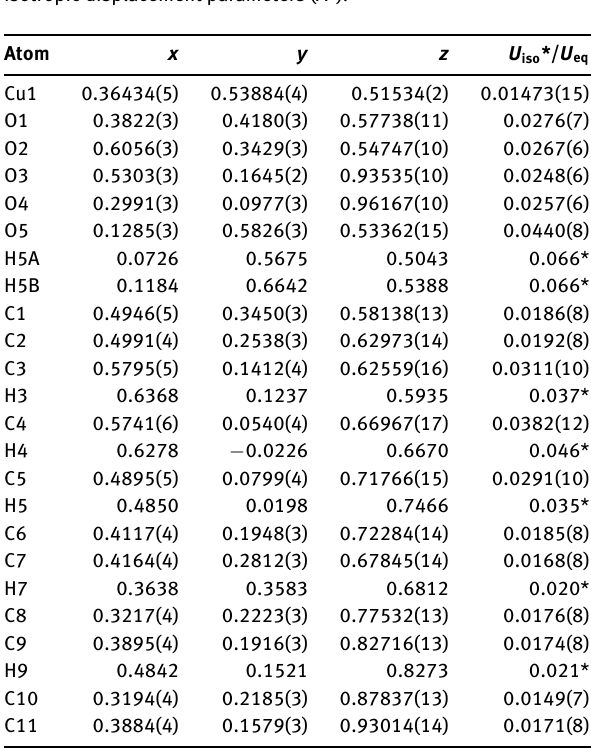
Table 2: Fractional atomic coordinates and isotropic or equivalent isotropic displacement parameters (Å 2